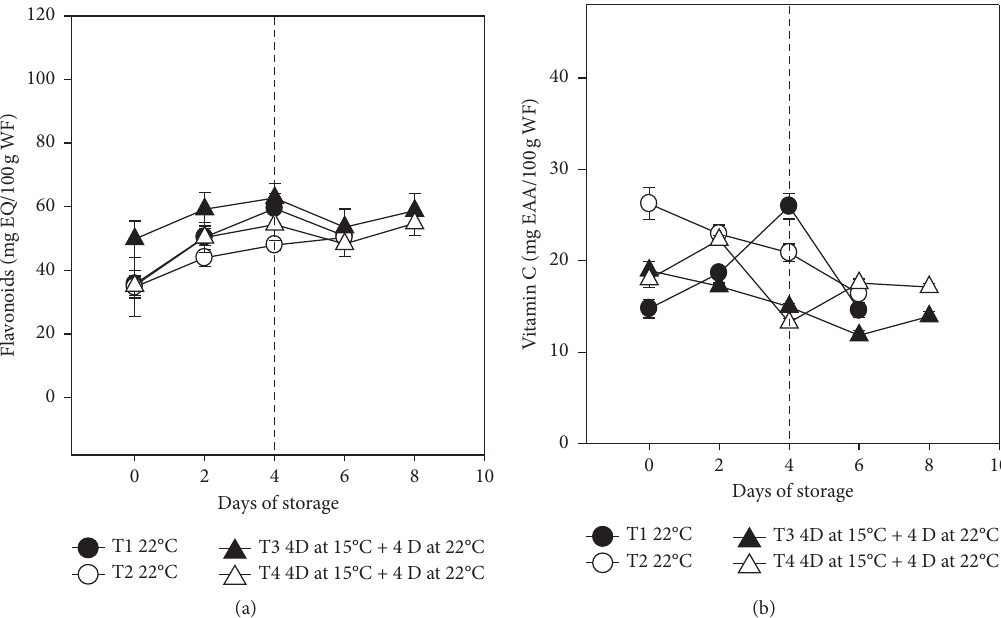
Figure 4: Flavonoid (a) and vitamin C (b) content in soursop fruits at 22 ° C and 15 ° C. Each point represents the average of 6 observations and its standard error. The dotted line indicates the end of refrigerated